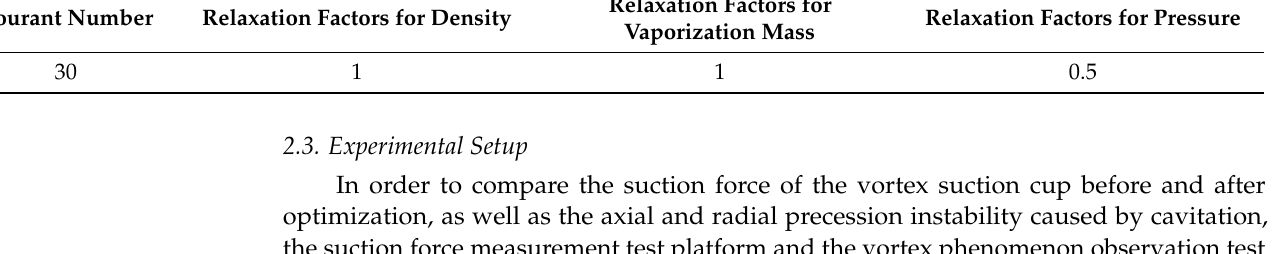
Figure 3. ( a ) Fluid computational domain for vortex suction cup; ( b ) mesh model of the fluid computational domain.